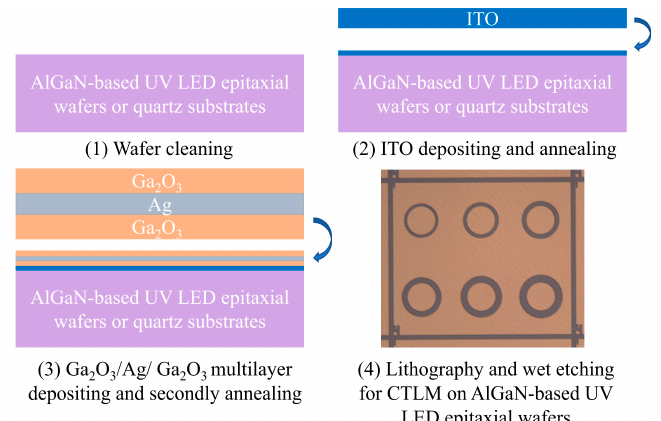
Figure 1. The procedures of making the indium tin oxide (ITO)/Ga 2 O 3 /Ag/Ga 2 O 3 multilayer and optical micrograph of contact surface morphologies on circular transmission line model (CTLM) patterns. The UV LED is the abbreviation of ultraviolet light-emitting diode.